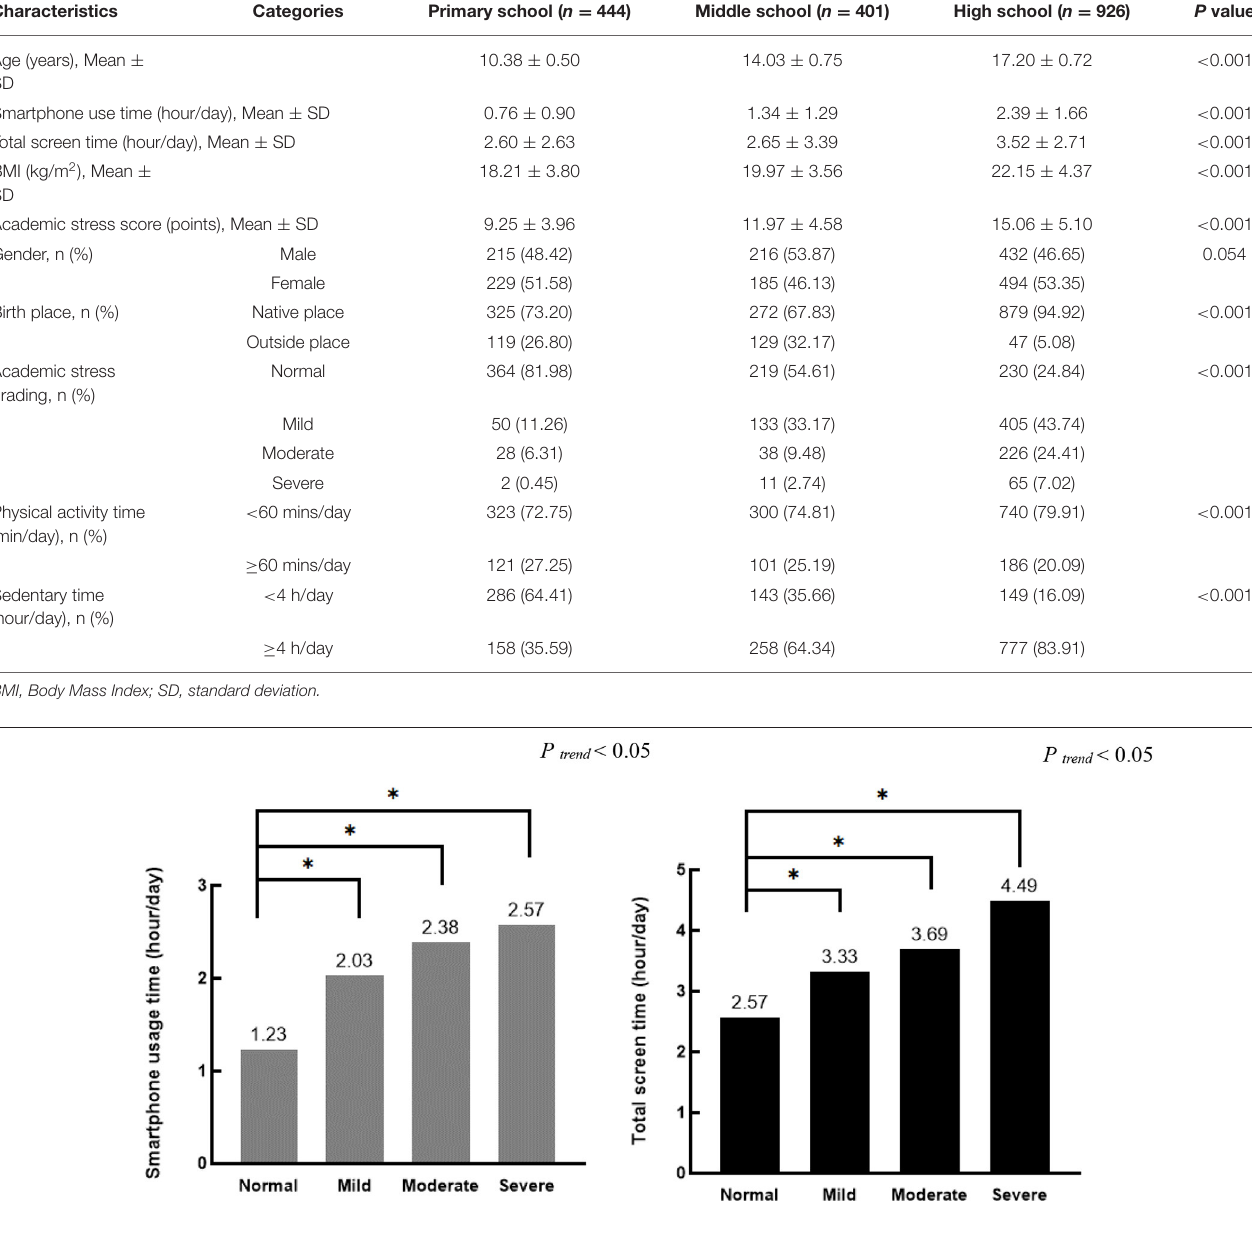
TABLE 1 | The general characteristics of study population stratified by grade group ( n = 1,771). Characteristics